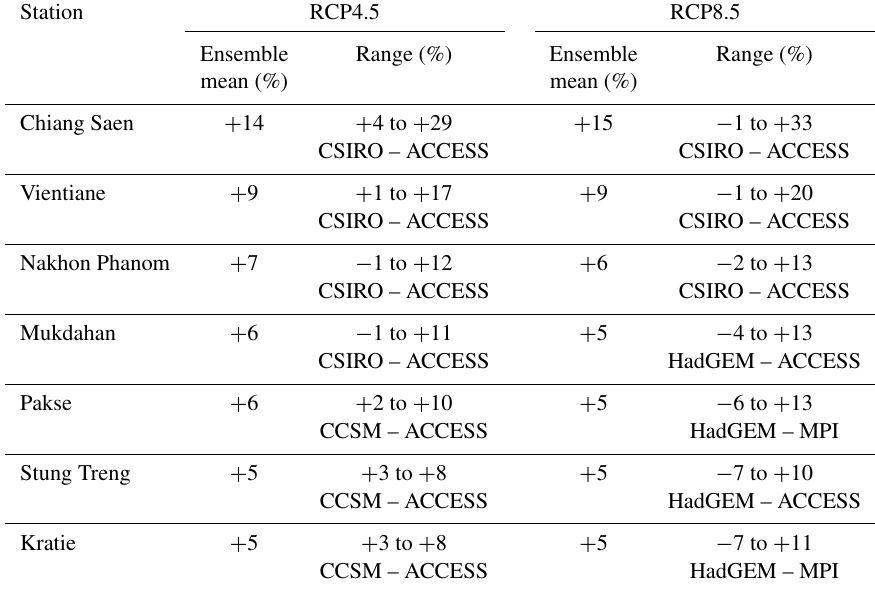
Table 3. Relative changes in annual river discharges at the Mekong’s mainstream stations for 2036–2065 relative to 1971–2000. The lowest and highest changes are presented with the corresponding climate change scenarios.